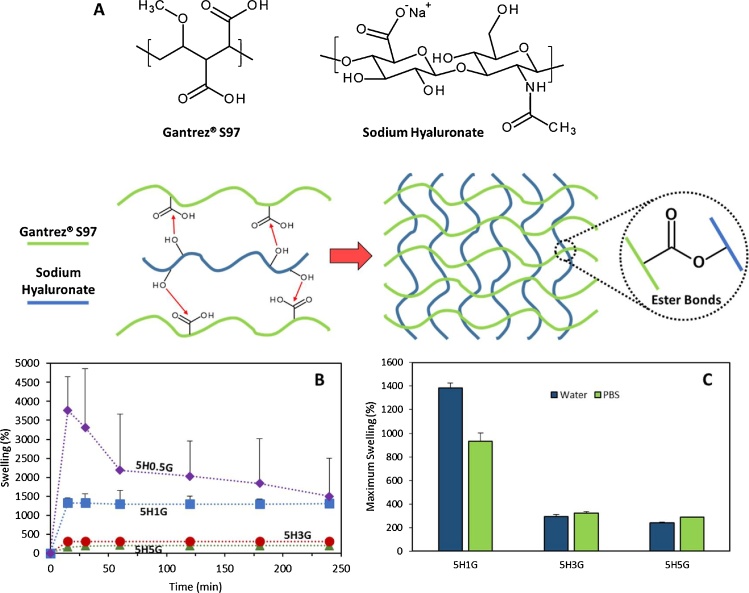
Chemical structures of Gantrez® S97 and sodium hyaluronate (top). Proposed crosslinking mechanism between Gantrez® S97 and sodium hyaluronate (A). Swelling kinetics of different HA/GAN hydrogels in water (B). Maximum swelling of different HA/GAN hydrogels in water and PBS (C).